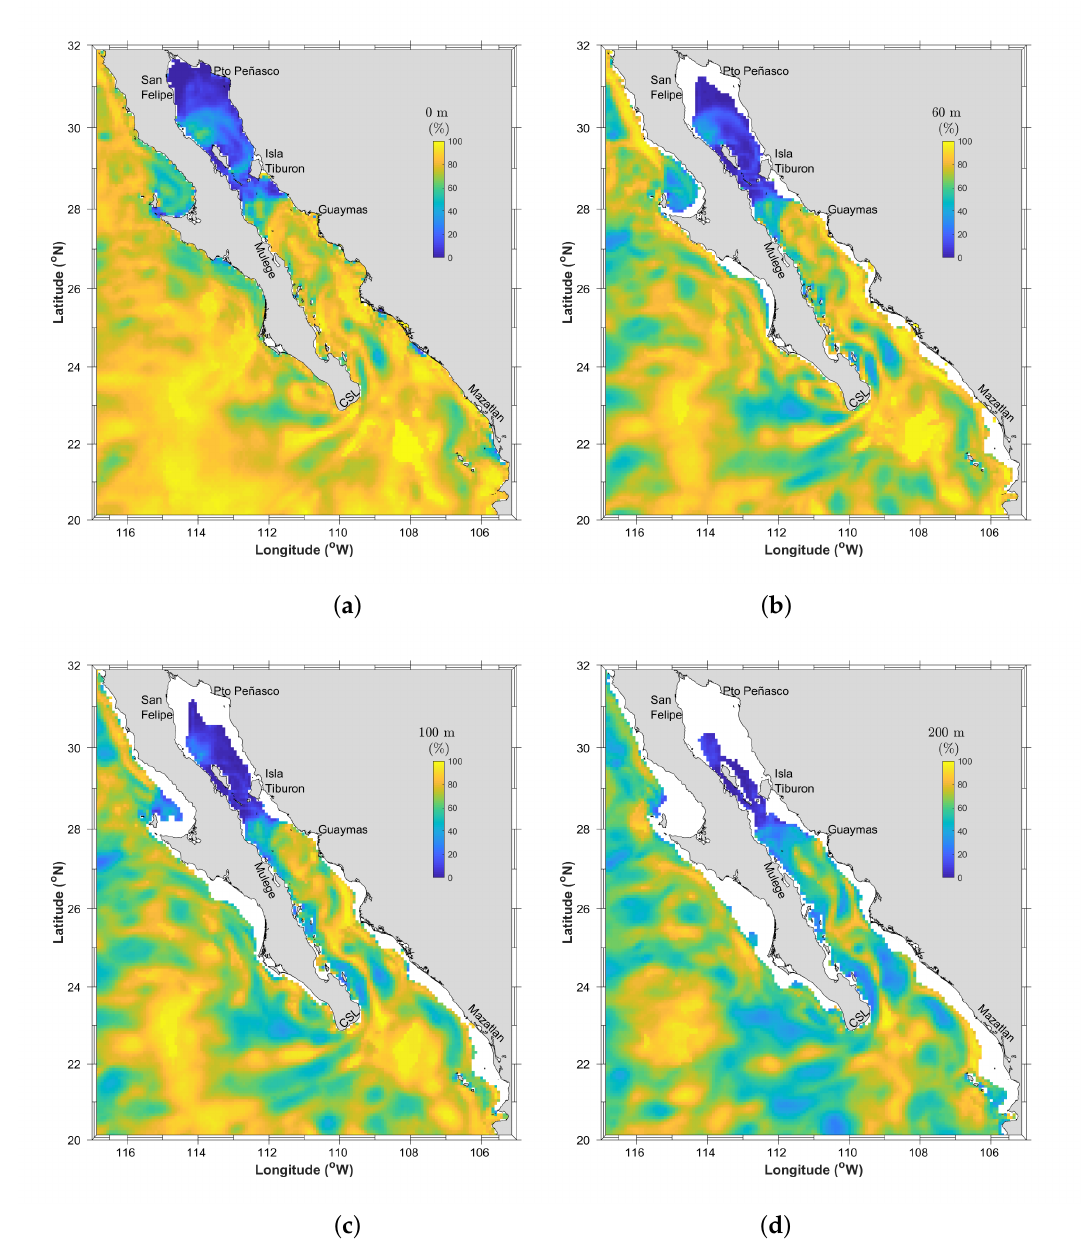
Figure 9. Relative importance of residual AEP against total AEP at ( a ) 0 m, ( b ) 60 m, ( c ) 100 m, and ( d ) 200 m below Mean Sea